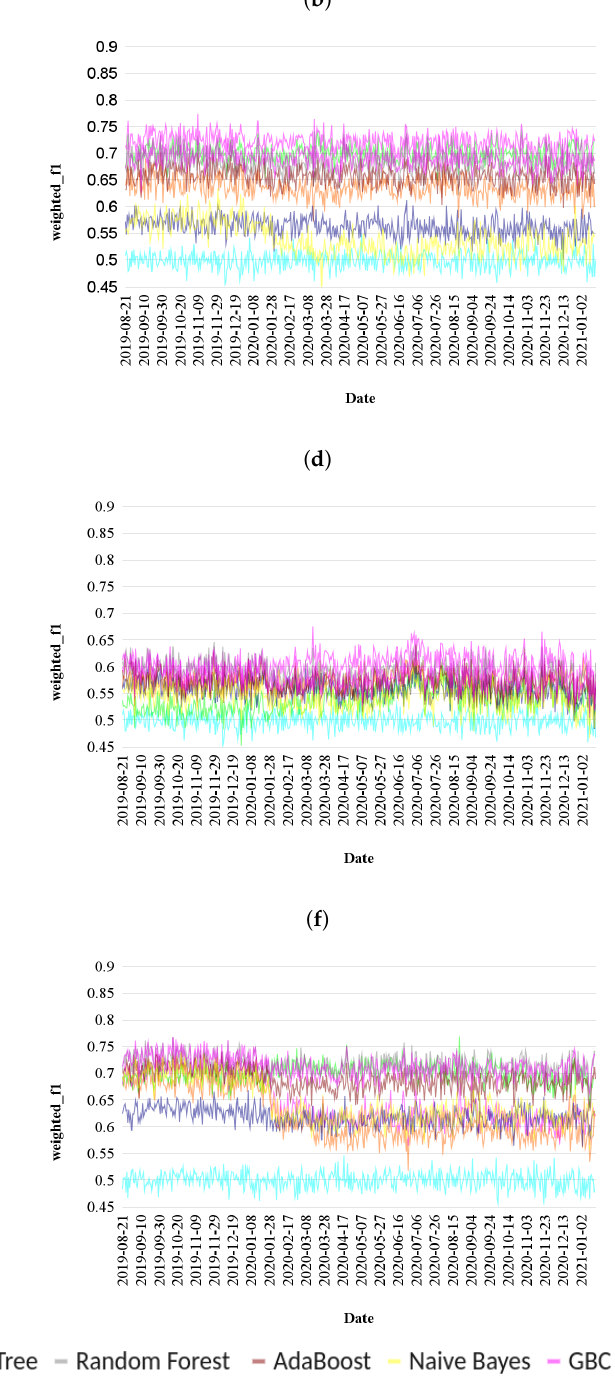
Figure 4. Performance evaluation (using weighted-f1) of different models for each feature set. ( a ) Bag of Words; ( b ) Google Word2Vec; ( c ) Fake Word2Vec; ( d ) Lexical Categories (Empath); ( e ) Context-free features; ( f ) Best 15